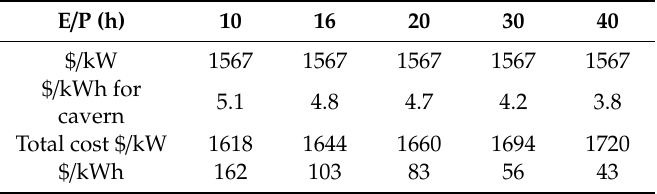
Table 34. CAES plant costs in $ / kW and $ / kWh for various e / p ratios or durations. E / P